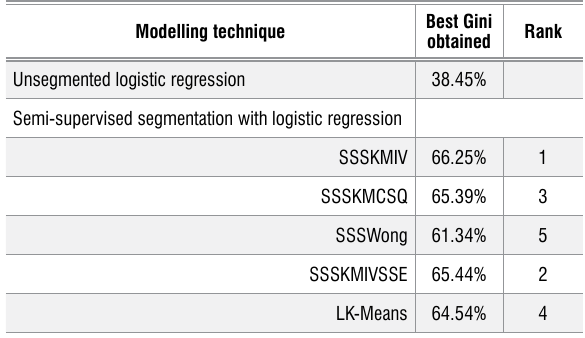
Credit application data set: comparison of performance of techniques